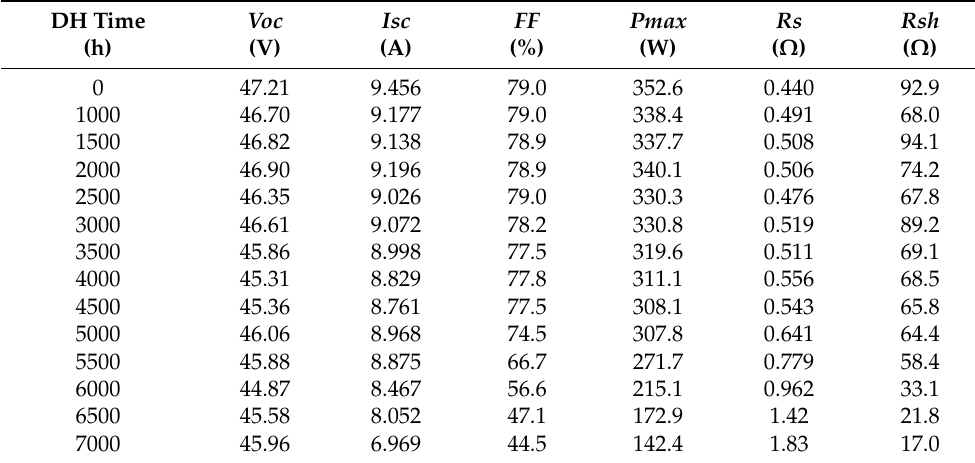
Figure 3. ( a ) Change of module performance parameters with respect to damp heat test times and corresponding ( b ) current–voltage and ( c ) power–voltage plots of selected modules. Table 1. Module performance parameters with time of damp heat test.